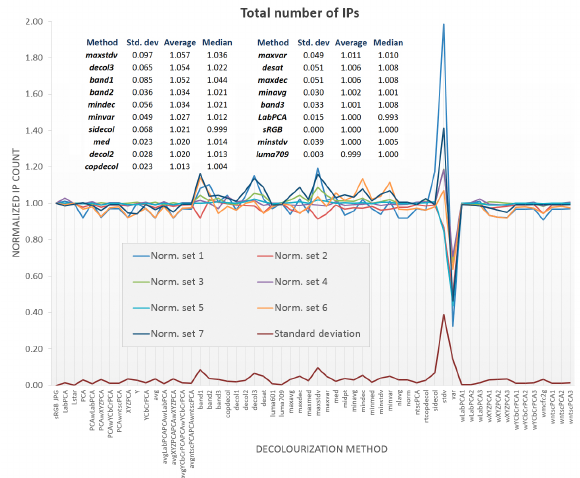
Figure 3. An overview of the number of IPs extracted by PSFE per conversion method and per image set (normalized to sRGB).